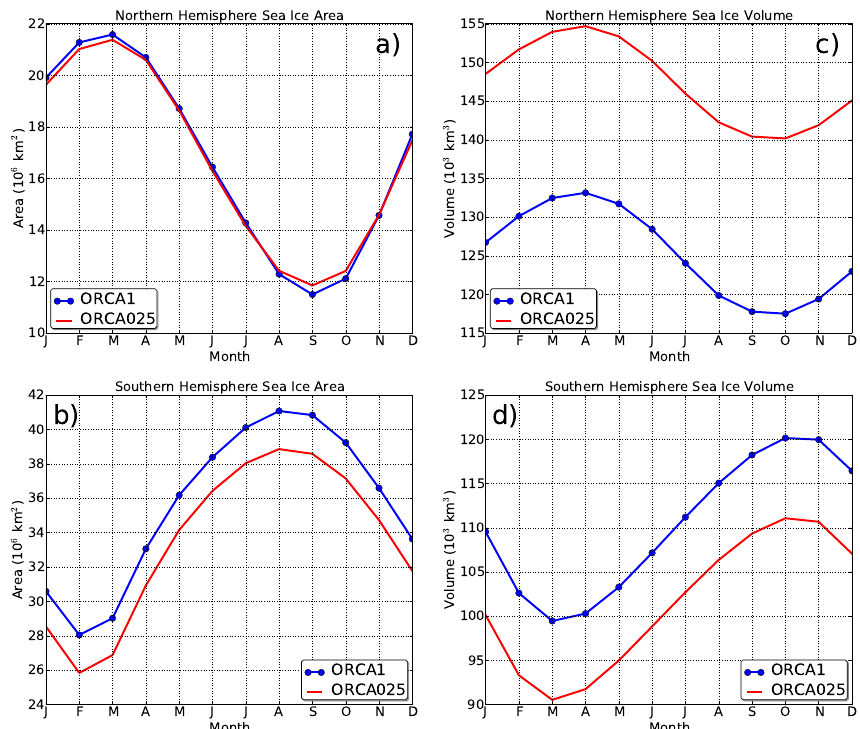
Fig. 5. Monthly mean of (a) the Northern Hemisphere sea-ice area, (b) the Southern Hemisphere sea-ice area, (c) the Northern Hemisphere sea-ice volume and (d) the Southern Hemisphere sea-ice volume for the eddy-permitting (ORCA025) and coarse (ORCA1) resolution